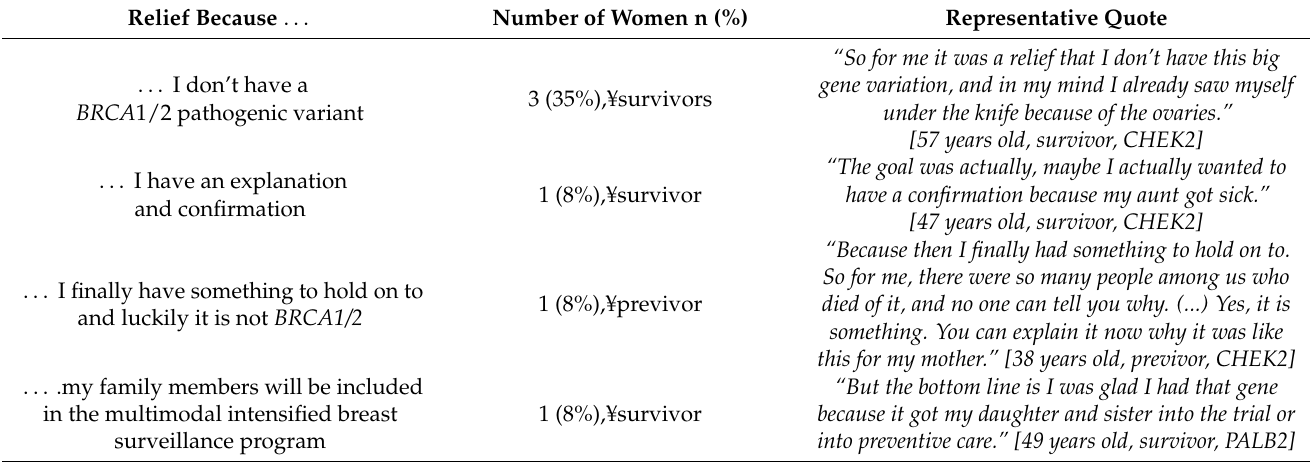
Table 3. Feelings associated with the disclosure of the genetic test result: Relief. Relief Because . . . Number of Women n